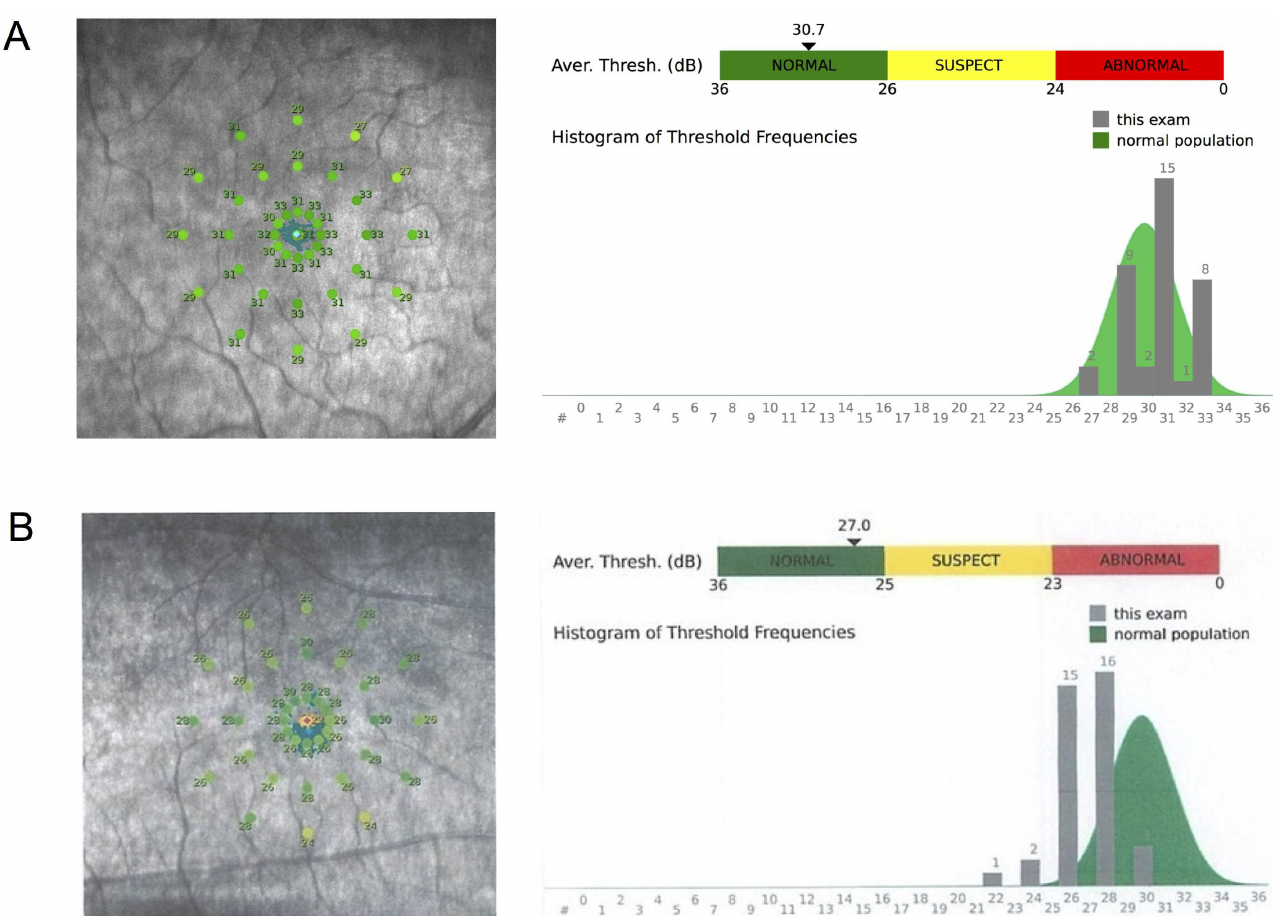
Fig 2. Evaluation of retinal sensitivity. The retinal sensitivities were obtained from 37 points within the central 10 degreesof the foveal center. The averageretinal sensitivity of the central 10˚, central 10˚ to 2˚, and central 2˚ were calculated. The macularintegrity assessment (MAIA) was used to determinethe retinal sensitivity. (A) Retinal sensitivity of a healthycontrol eye. Retinal sensitivities obtainedfrom each point are shown on the left. The averagesensitivity of central 10˚ and the histogramof thresholdfrequencies comparedwith built-in databaseof normalpopulationare shown on the right. (B) Retinal sensitivity of an eye with neuromyelitis optica spectrum disorder(NMOSD). The patient was a 66-year-old woman who had history of longitudinally extensive transverse myelitis and was positive for serum autoantibody againstaquaporin-4. The averageretinal sensitivity of the central 10˚ was 27.0 dB whereasthe averagesensitivity of healthy control eyes was 29.39 dB.